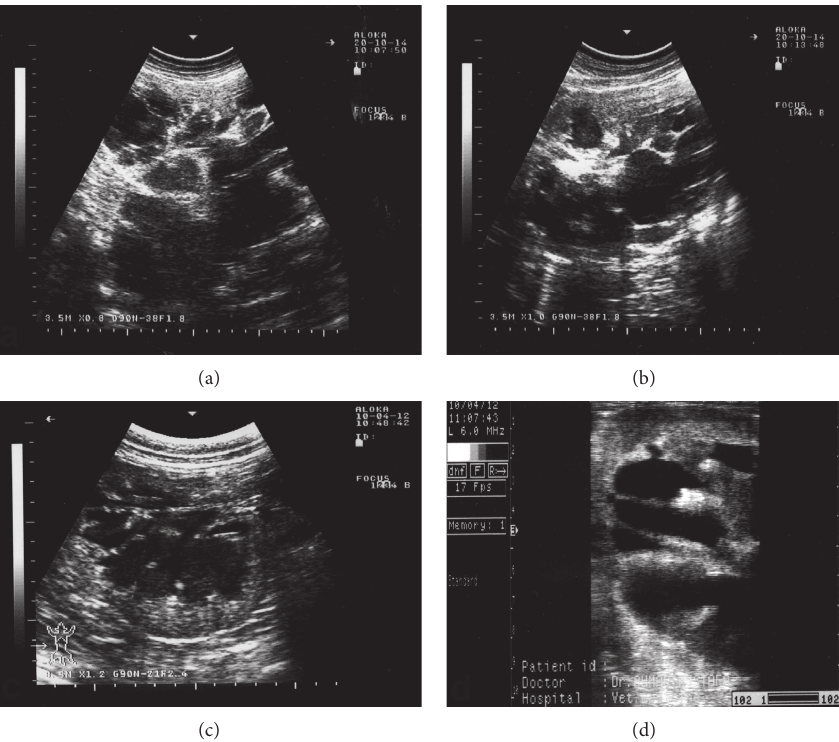
Figure 11: Bilateral hydronephrosis in two female camels with urinary calculi. Both the right (a) and left (b) kidneys were scanned transcutaneously. In the other case, the right kidney (c) was imaged transcutaneously and the left kidney (d) was imaged